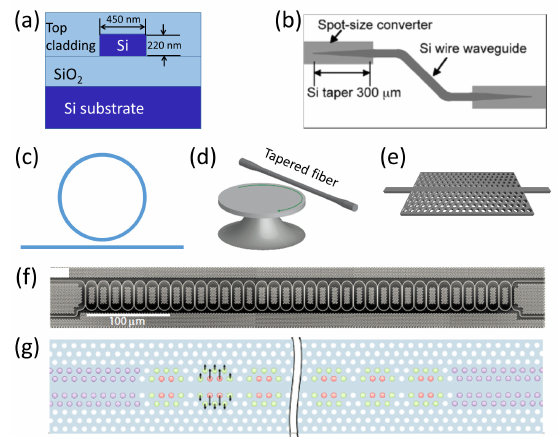
Fig. 4. Diagrams for (a) the cross section of a typical nanowire, (b) a nanowire with inversed tapers [41], (c) the top view of a typical microring, (d) a microdisk [32], (e) a photonic crystal waveguide (PhCW) [33–35], (f) a microring CROW [36], and (g) a PhC CROW [37].